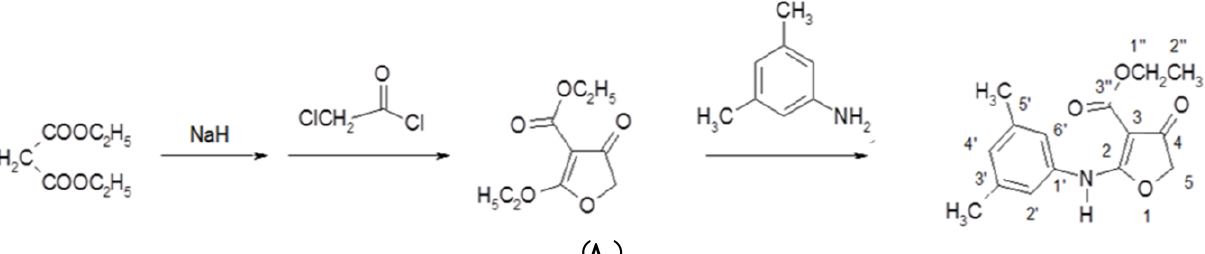
Figure 1. Cont Figure 1. Cont.